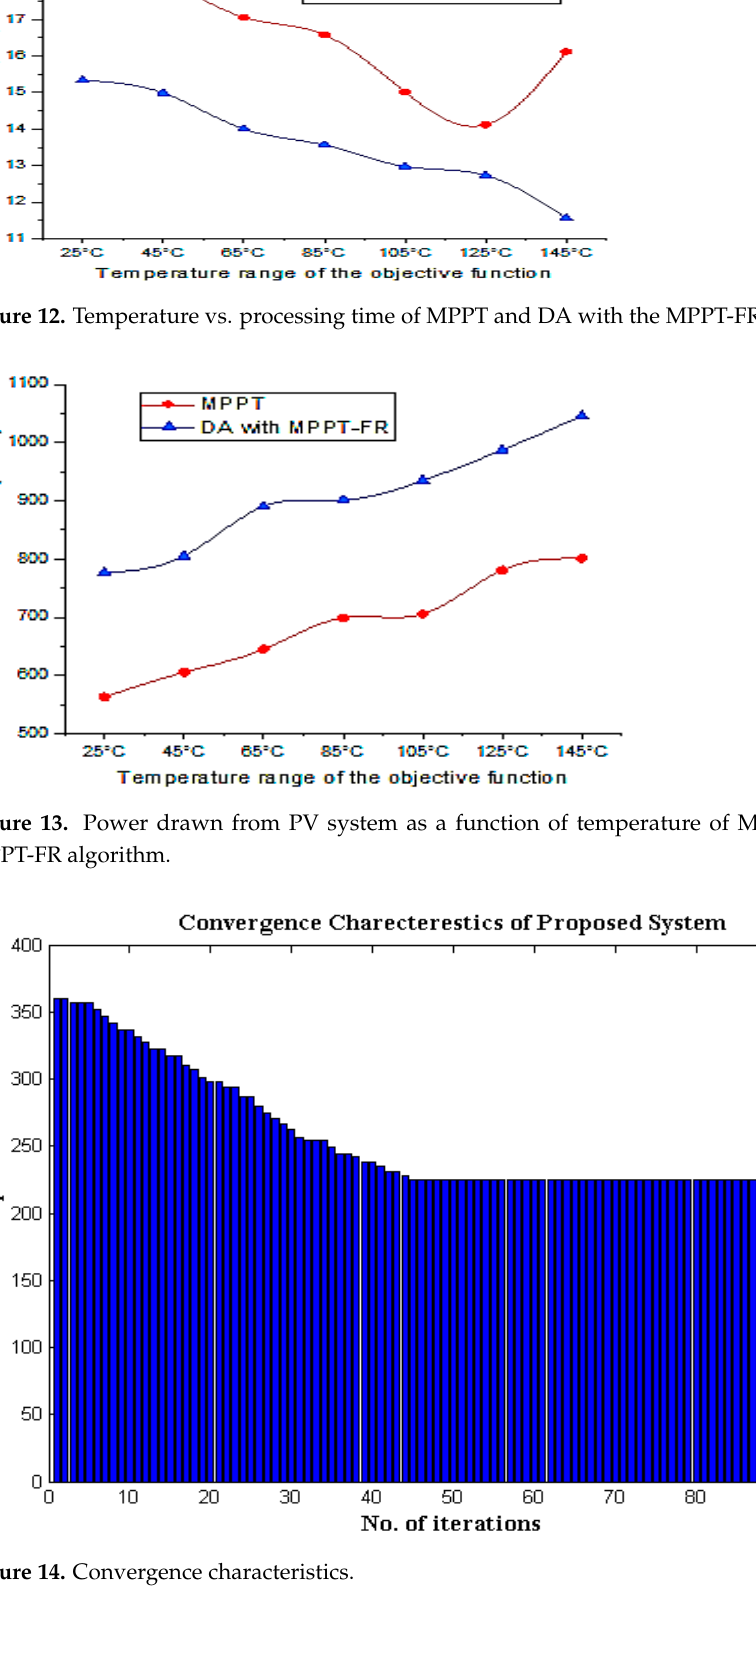
Figure 15. Robustness characteristics. 5. Conclusions This manuscript is proposed with novel MPPT-forward and reverse flow technique with the dragonfly concept. By using this algorithm the maximum amount of energy is drawn from solar with a minimum of processing time. The multi-objective problem is focused in the analysis. The analysis is focused and simulated to trace maximum tem-